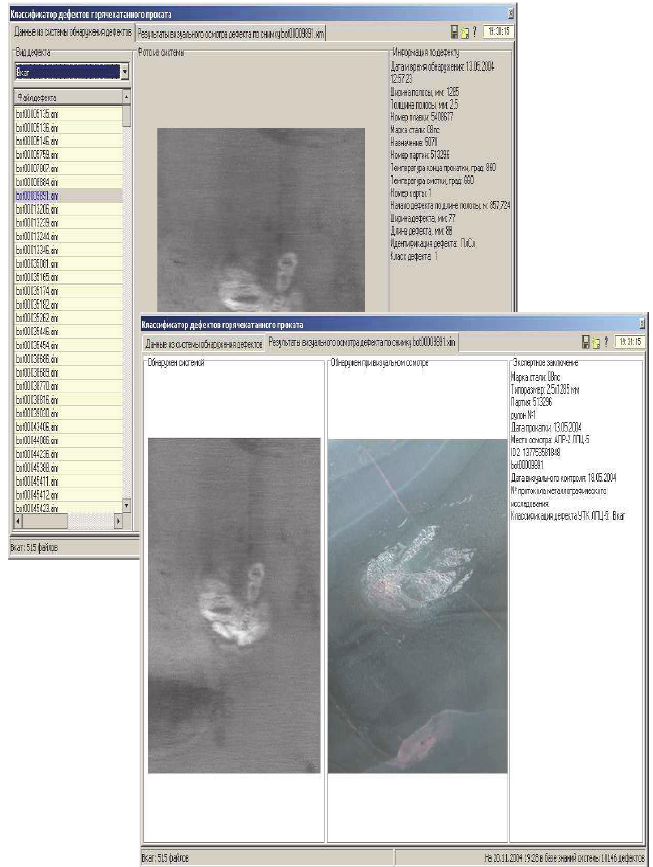
Figure 2: Digital catalogue of defects of surface of hot rolled